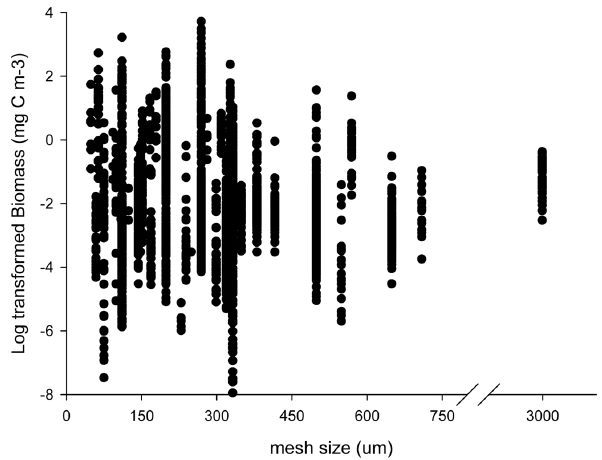
Figure 1. The relationship between net mesh size and pteropod biomass.